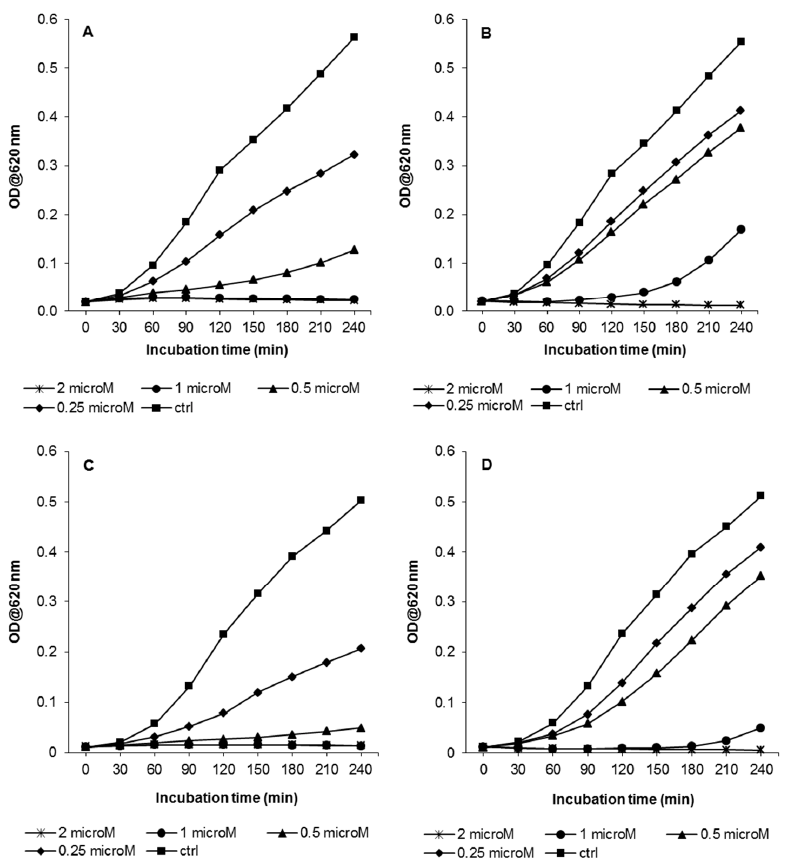
Figure 2. Growth kinetics of KpTs101 and KpTs113 strains in presence of Bac7(1–35) or BMAP-27. Bacterial suspensions (10 6 cells/mL) were grown for 4 h in presence of the indicated concentrations of peptides, and the OD 620 was measured every 10 min. The results are the means of three independent experiments. ( A ) KpTs101/Bac7(1–35); ( B ) KpTs101/BMAP-27; ( C ) KpTs113/Bac7(1–35); ( D ) KpTs113/BMAP-27.